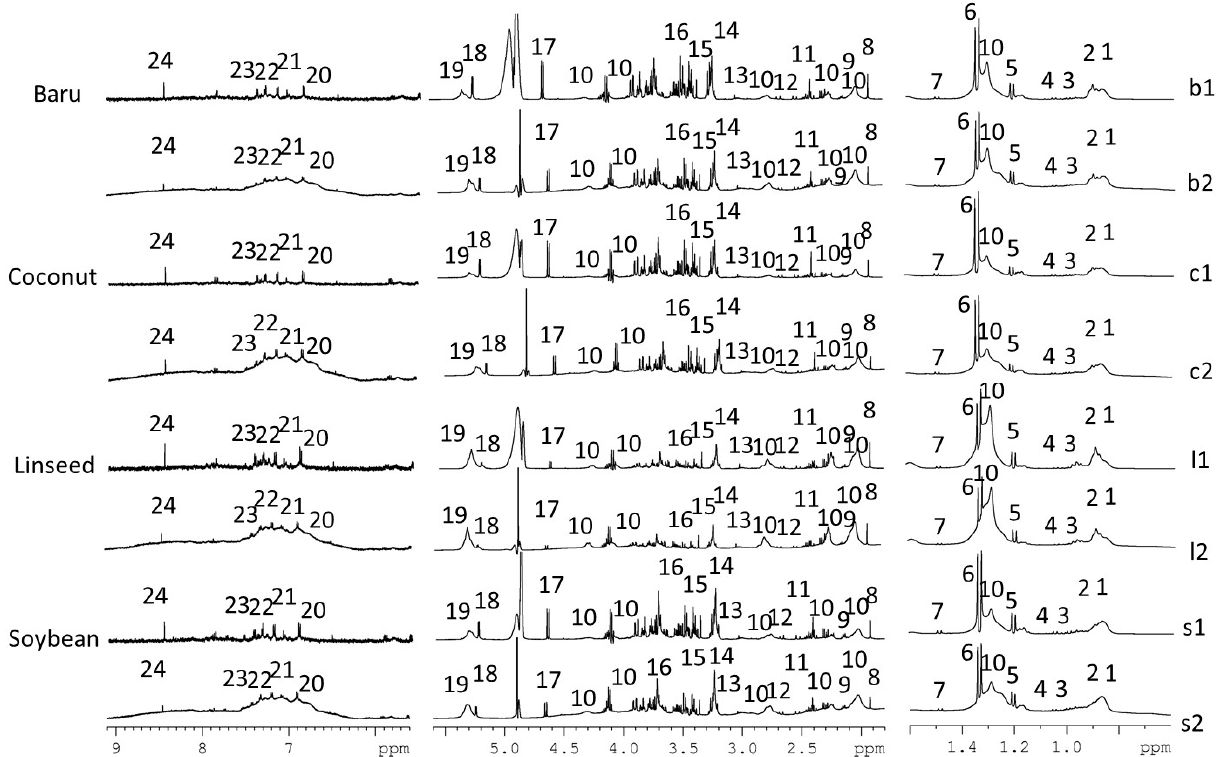
Figure 1. Representative 1 H NMR spectra (500 MHz, D 2 O buffer pH 7.2) of mice serum from